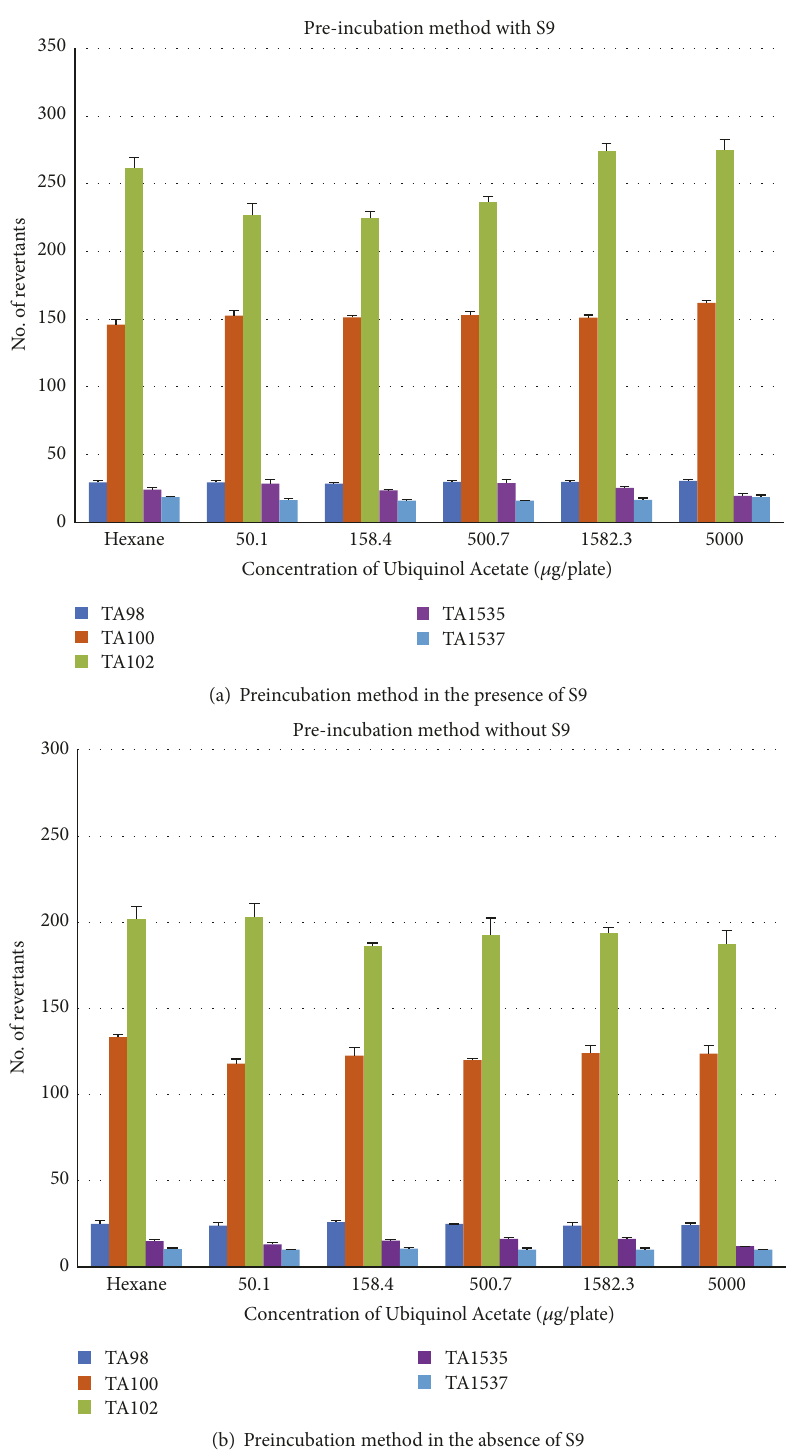
Figure 2: Effect of ubiquinol acetate on number of revertants in preincubation method using Salmonella typhimurium tester strains in the presence (a) and absence (b) of metabolic activation. Each concentration was tested in triplicate (n = 3) and the values are represented as mean ±